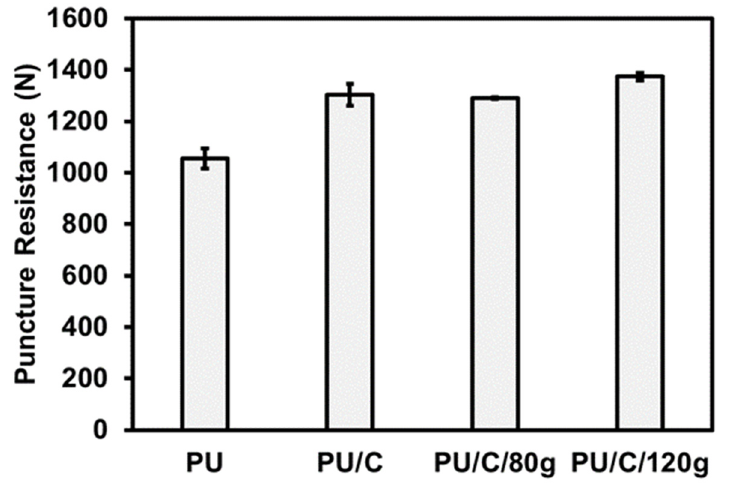
Figure 6. Puncture resistance of PU foam composite planks in the falling weight stab resistance test.